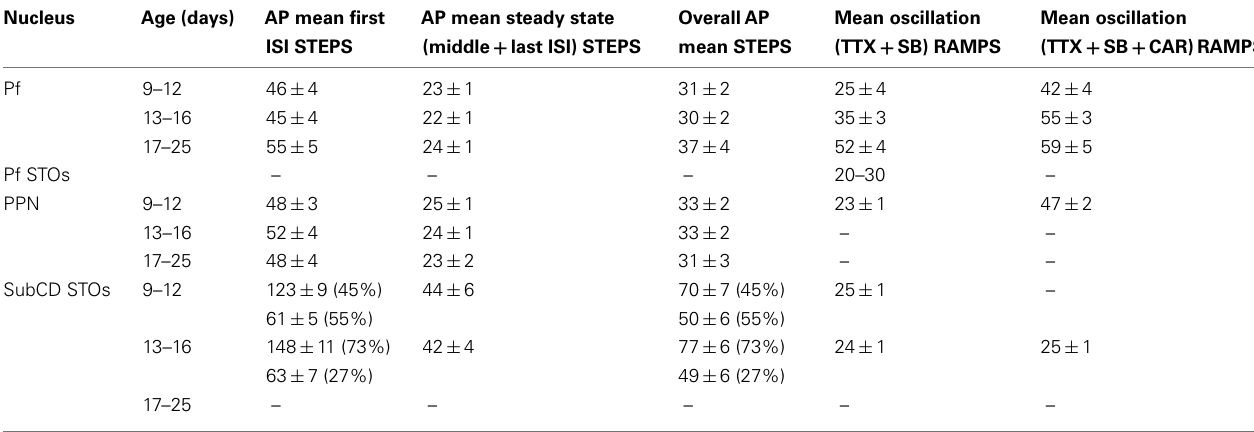
Table 1 | Frequency in Hz of induced action potentials (AP) during STEPS, membrane oscillations during RAMPS, and after CAR.